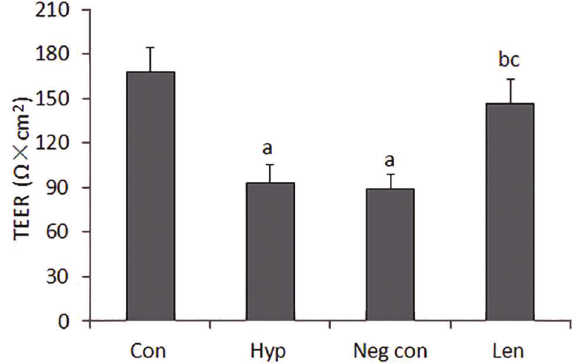
Figure 4. In fl uence of HIF-2 a on the permeability of rat glomerular endothelial cells. Data are reported as means ± SD (ANOVA). Con: control group; Hyp: hypoxia group; Neg con: Negative control group; Len: HIF-2 a lentivirus transfected group. a P o 0.01 compared with control group; b P o 0.01 compared with hypoxia group; c P o 0.01 compared with Neg con group